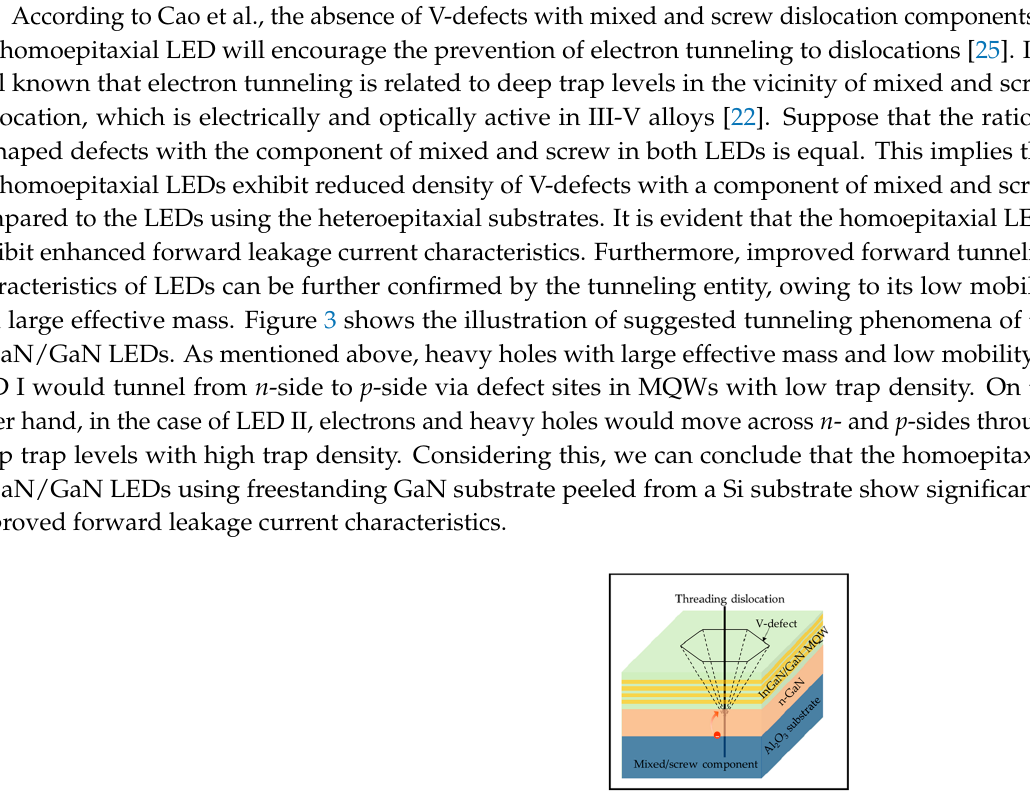
Table 1. Summary of tunneling analysis of LED I and LED II. The obtained values are deduced from Equation (3).